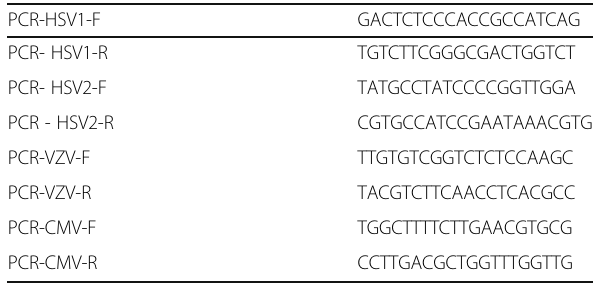
Table 2 The primers of